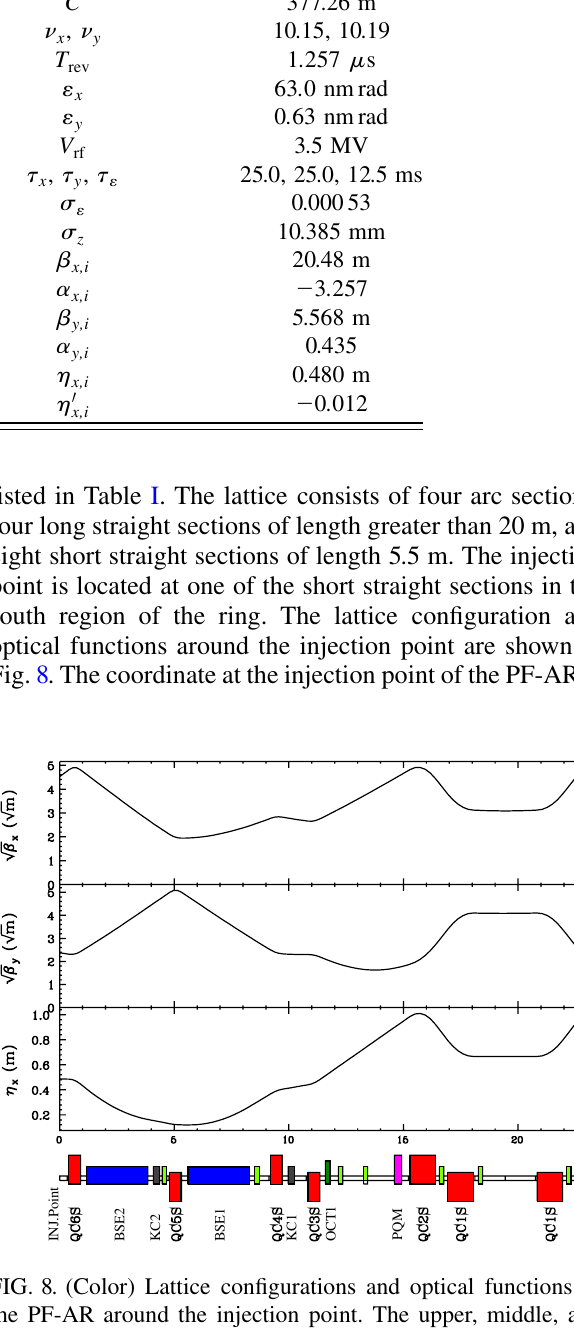
FIG. 8. (Color) Lattice configurations and optical functions of the PF-AR around the injection point. The upper, middle, and lower parts show the square root of the horizontal betatron p , square root of the vertical betatron function function (cid:1)(cid:1)(cid:1)(cid:1)(cid:1)(cid:1) (cid:2) x p , and horizontal dispersion function (cid:11) (cid:1)(cid:1)(cid:1)(cid:1)(cid:1)(cid:1) (cid:2) , respectively. The y x rectangular boxes indicate bending magnets (BSE2 and BSE1), quadrupole magnets (QC6S, QC5S, QC4S, QC3S, QC2S, and QC1S), octupole magnets (OCT1), kicker magnets (KC1 and KC2), and a pulsed quadrupole magnet